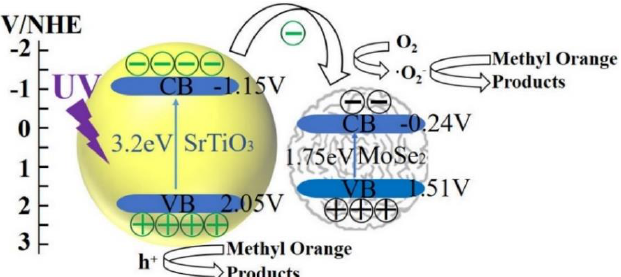
Figure 8. Mechanism of a MoSe 2 /SrTiO 3 photocatalyst to oxidize and degrade methyl orange dyes in wastewater. UV irradiation causes electron transfer from the valence band (VB) to the conduction band (CB), which activates the separation process (Reproduced with permission from [200]. Copyright 2018 World Scientific Publishing Co Pte Ltd CC BY Under Open